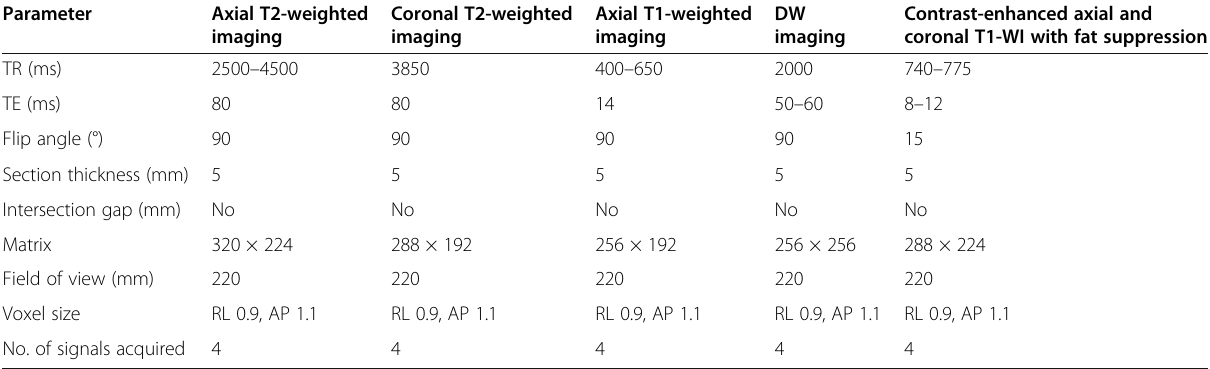
Table 1 MR imaging